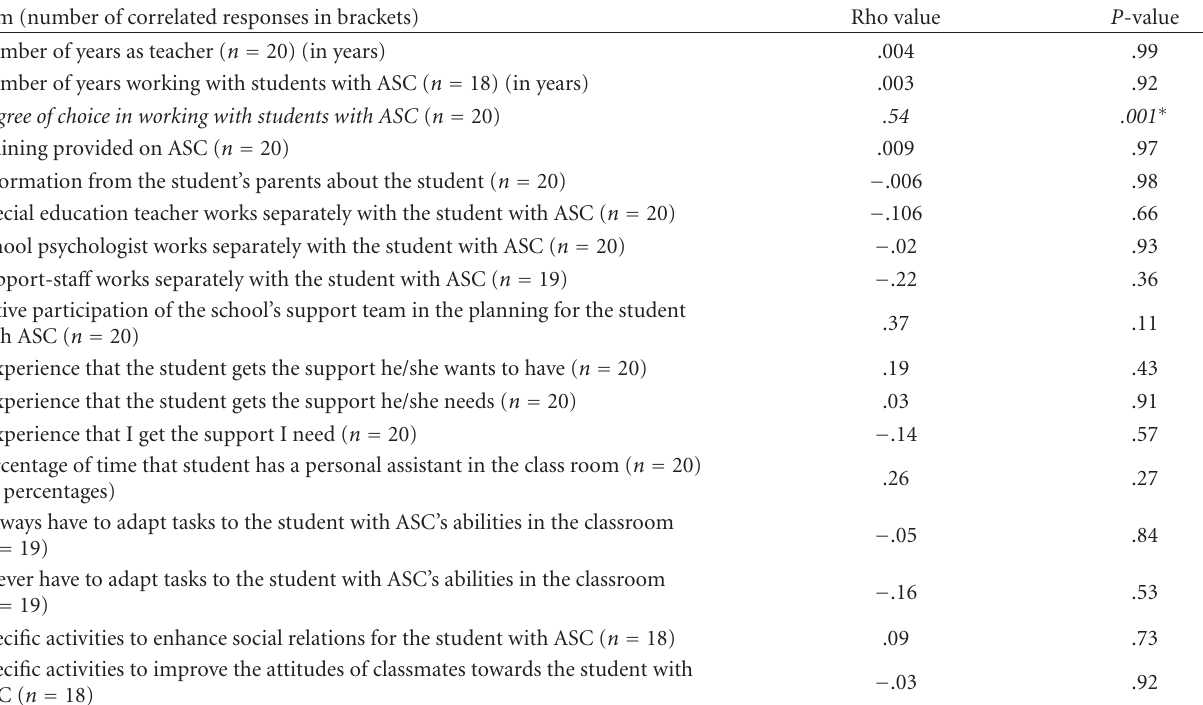
Table 4: Correlation analyses between agreement (measured as the sum of total agreement and near agreement) and teachers’ self-reported professional experiences, perceived support, personal interests, and planned activities. Ratings were done on a 5-step Likert scale unless otherwise indicated. ∗ Indicates a significant correlation, and n indicates the number of